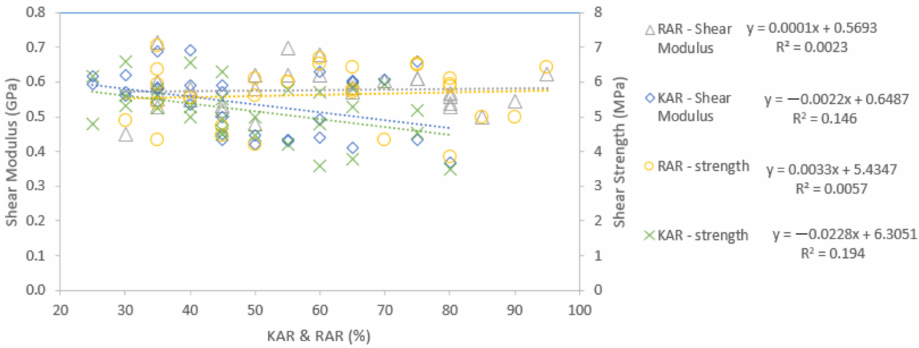
Figure 25. KAR and RAR vs. Shear Modulus and shear